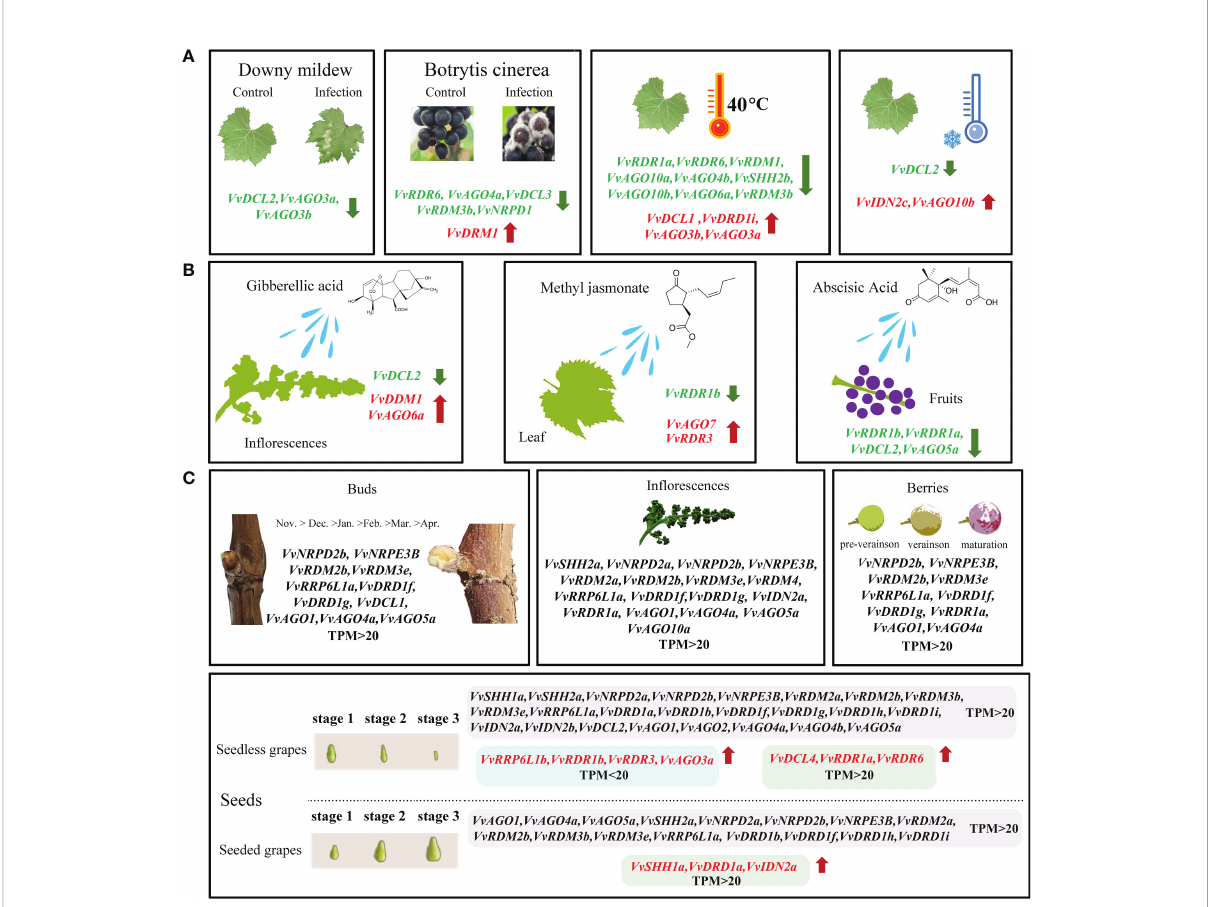
FIGURE 11 Transcriptomic and expression analysis of grapevine VvRdDM genes. The green and red font represents signi fi cant down and up-regulation, respectively. (A) The differential expression of VvRdDM genes following different biotic (downy mildew, botrytis cinerea), and abiotic (heat, cold) treatments. (B) The differential expression of VvRdDM genes under hormone treatments (GA 3 , MeJA, ABA). (C) The expression of VvRdDM genes in different organs: buds, in fl orescence, seeds, and berries. The genes having TPM>20 are listed. In the seeds, the red font indicates that the expression was signi fi cantly up-regulated during the seed development in the seedless cultivars as compared with the seeded cultivars and vice